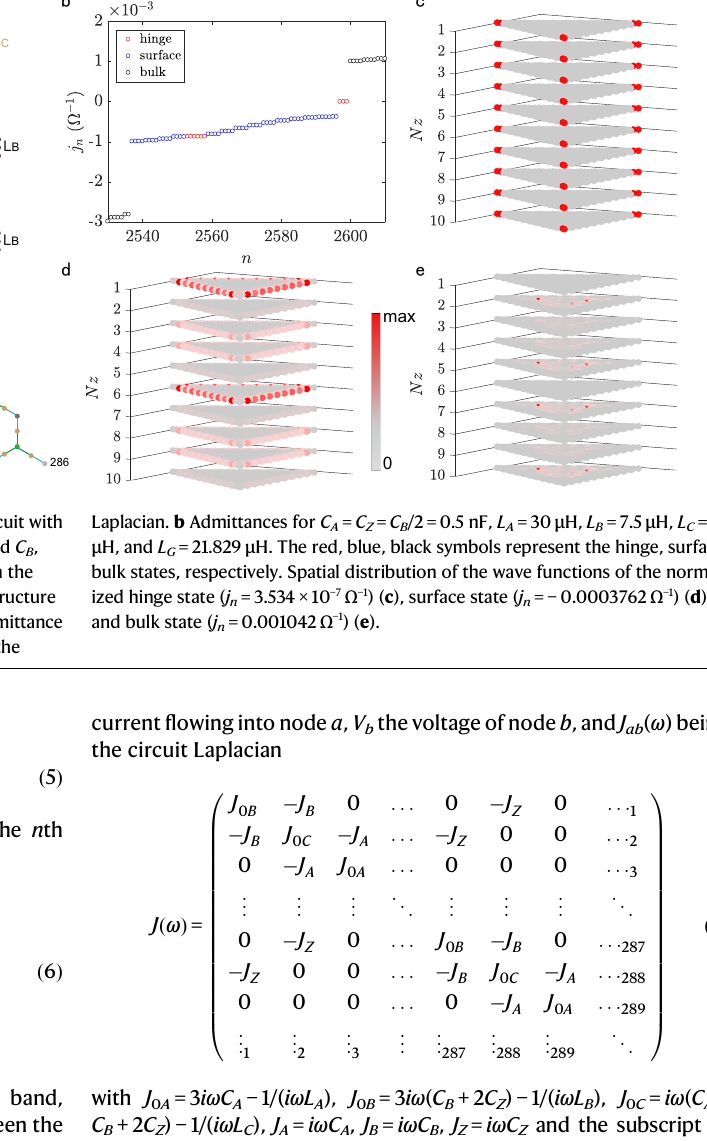
the dots indicating the column/row numbers. Under the resonance